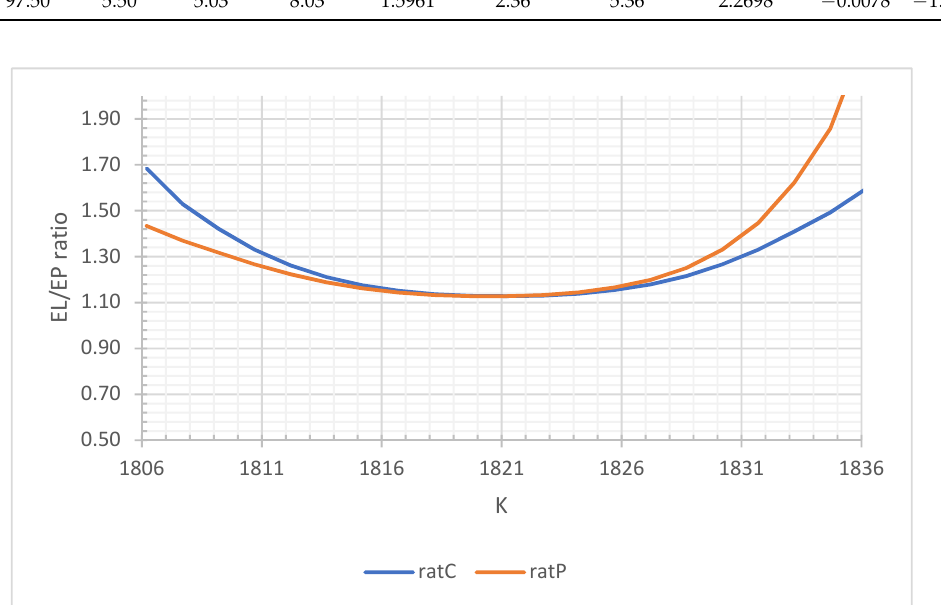
Figure 2. Call and put binaries EL/EP ratios vs strikes for Nadex Gold data of 8 February 2022 based on Nadex PITM assessments.